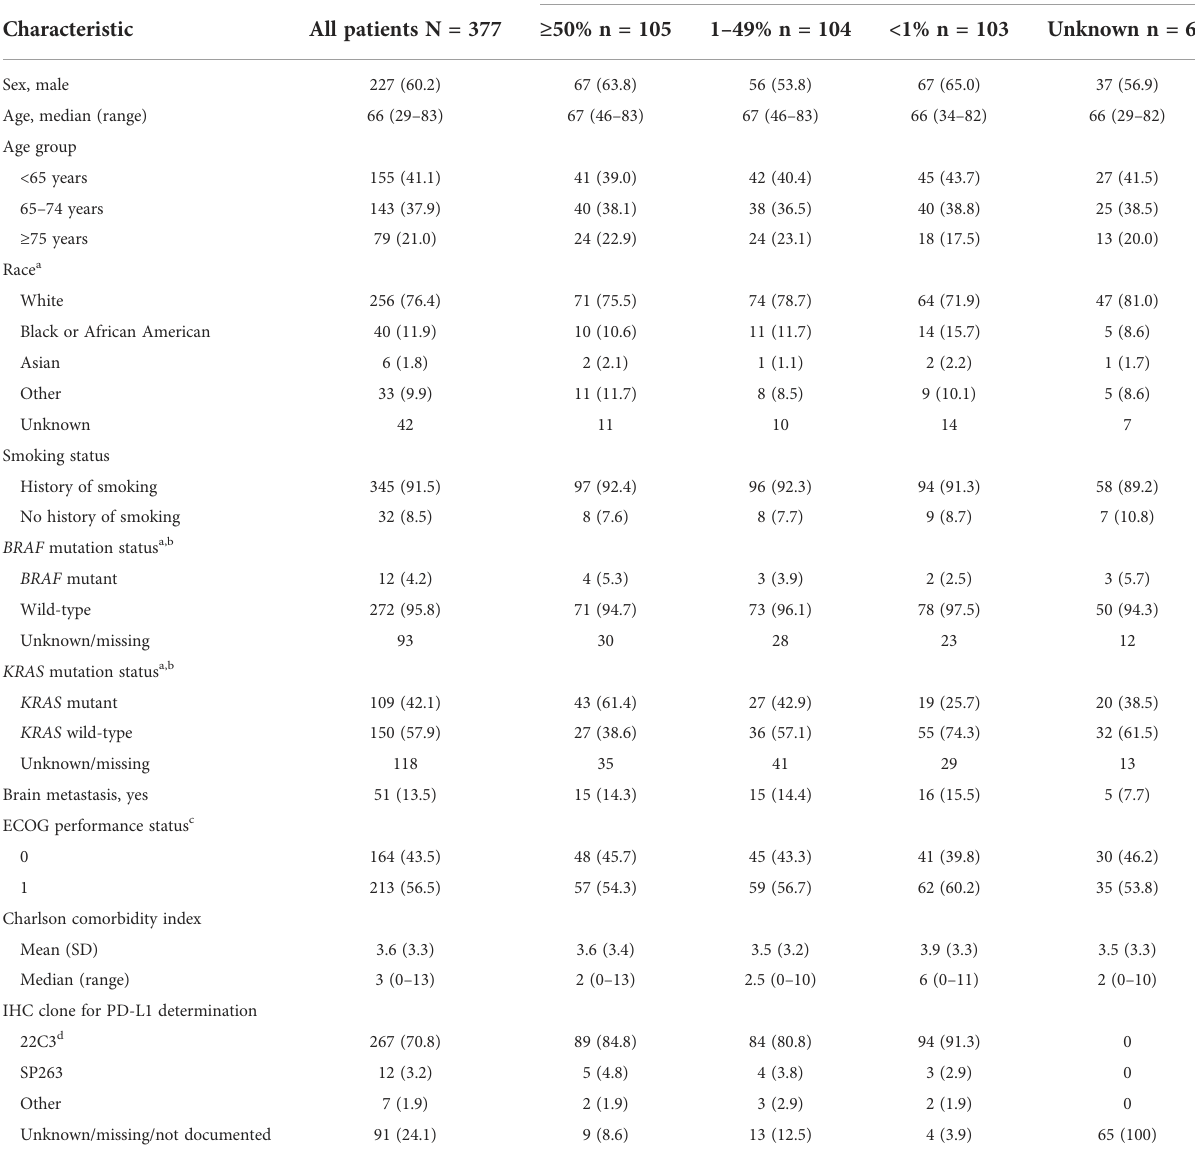
TABLE 1 Patient characteristics at initiation of fi rst-line pembrolizumab-combination